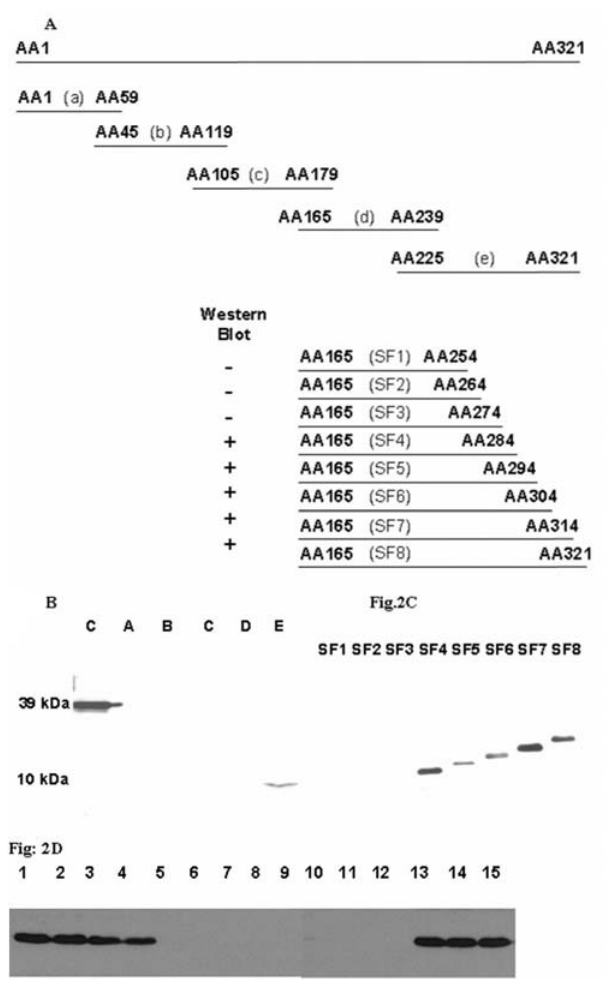
Figure 2. Mapping the mAb 5F8 epitope. (A) Fragments of the H5 HA coding region (termed ‘‘a’’ through ‘‘e’’ and SF1 to SF8; their boundaries indicated by N terminal and C terminal codon positions in HA) were expressed as histidine N-terminal-tagged fusion proteins. mAb 5F8 binding to fragments ‘‘a’’ through ‘‘e’’ (B) and sub-fragments SF1 to SF8 (from fragments ‘‘d’’ and ‘‘e’’) in Western blot (C). + : rH5HA1 protein used as control. Western blot analysis of histidine-tagged HA sub-fragments (SF3 and SF4) with single amino acid substitutions revealed that binding by mAb 5F8 depends on the presence of specific amino acids spanning positions 274–281 (D).